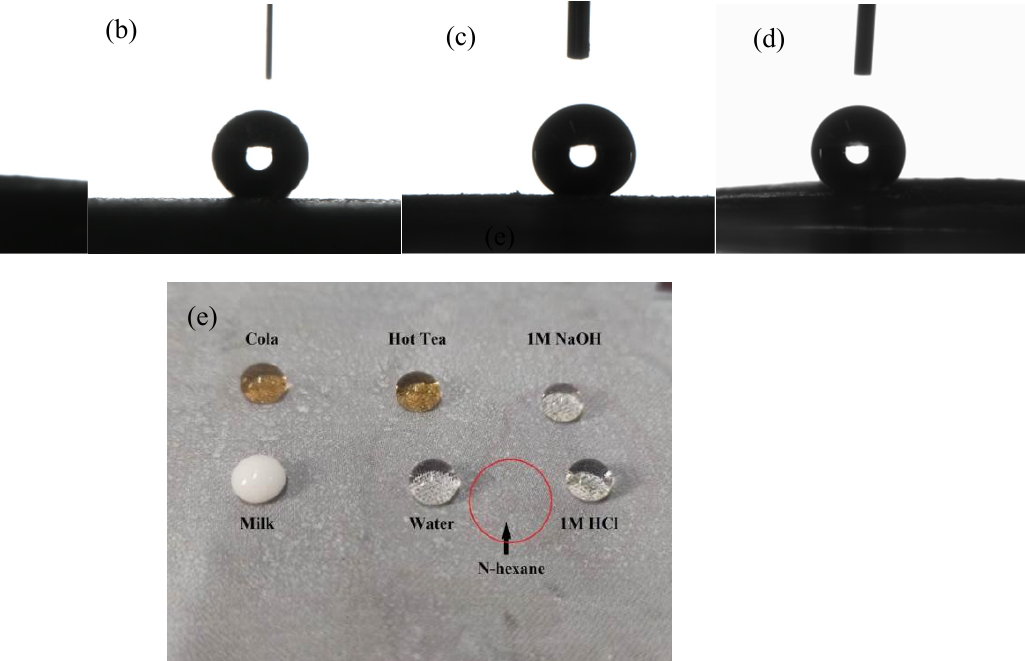
Figure 4. Variation of water contact angles on the superhydrophobic coating composed of PDMS/TiO 2 fiber at pH values ranging from 1 to 14: pretreated mesh ( a ), pH = 7 ( b ), pH = 1 ( c ), pH = 14 ( d ), and the photograph of different liquids on the SSM ( e ).